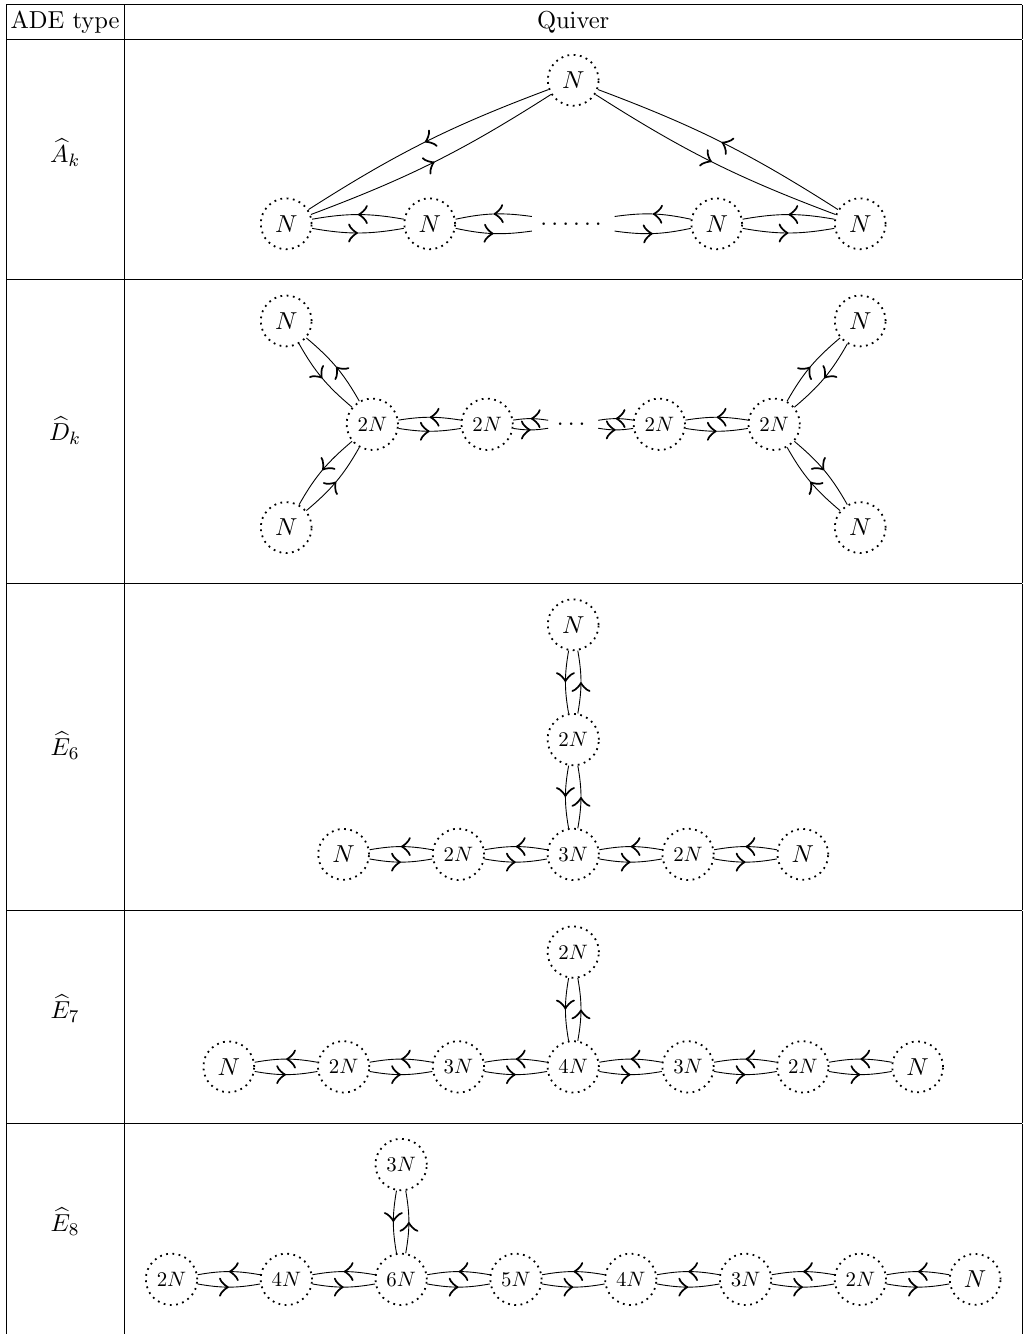
Table 1 . Punctures for M5-branes probing an ADE singularity are speci(cid:12)ed in terms of Nahm pole data in an associated 5D gauge theory obtained by reduction on a circle. This is a 5D a quiver gauge theory with nodes and links (cid:12)elds speci(cid:12)ed by the corresponding a(cid:14)ne ADE Dynkin diagram. Each quiver node has gauge group U( d i N ) where d i is the Dynkin index of the node and N is the total number of M5-branes probing the singularity.